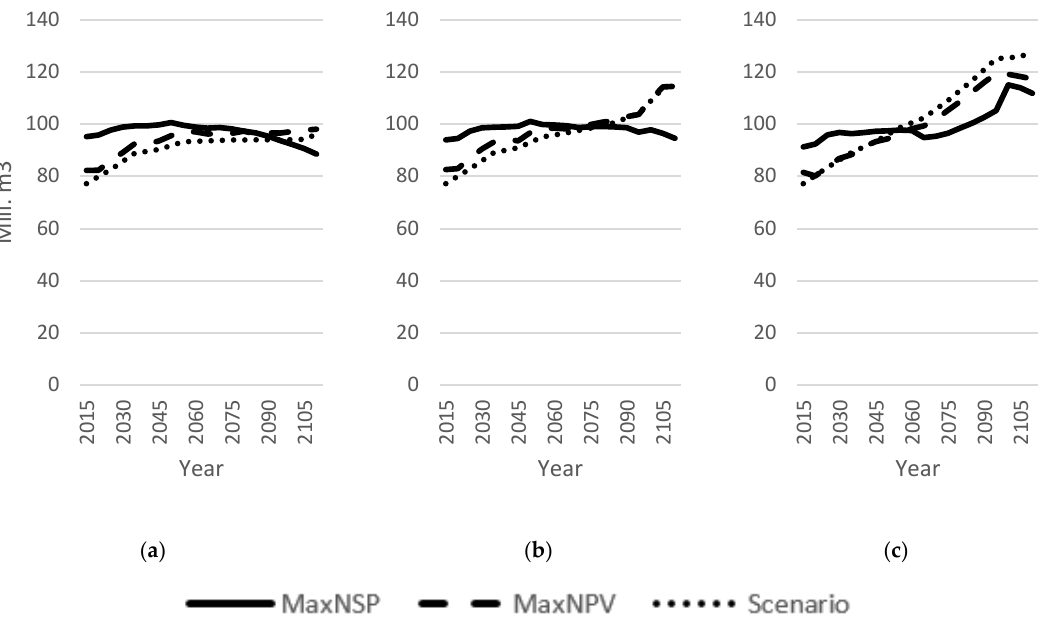
Figure 3. Total national harvest volume entering sawmills, pulp mills and heating plants for three scenarios computed with SweFor for demand specifications MaxNSP and MaxNPV (m 3 o.b. including treetops) and the harvest volume specified in the GLOBIOM national scenario destined for sawmills and pulp mills. ( a ) Scenario RCP4p5.SSP3; ( b ) scenario RCP2p6.SSP4; ( c ) scenario RCP2p6.SSP5.